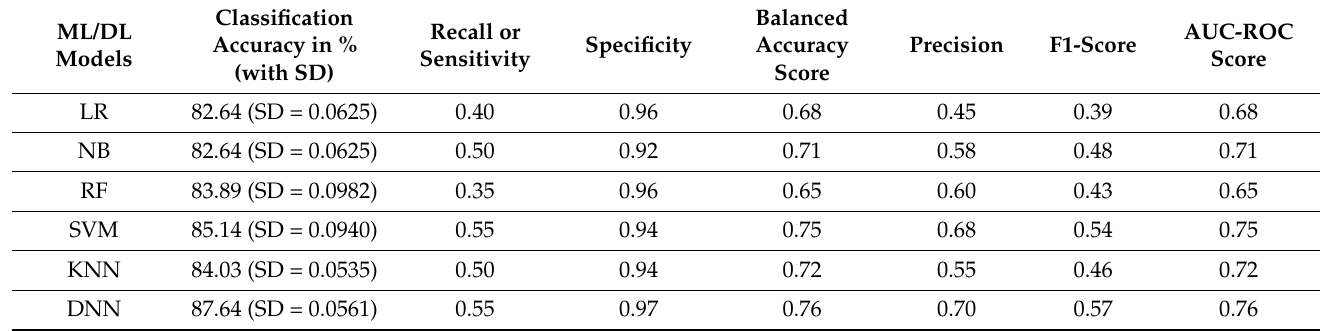
Figure 15. The pictorial representation of comparative accuracy estimation using different ML/DL models based on the stratified ten-fold cross-validation.